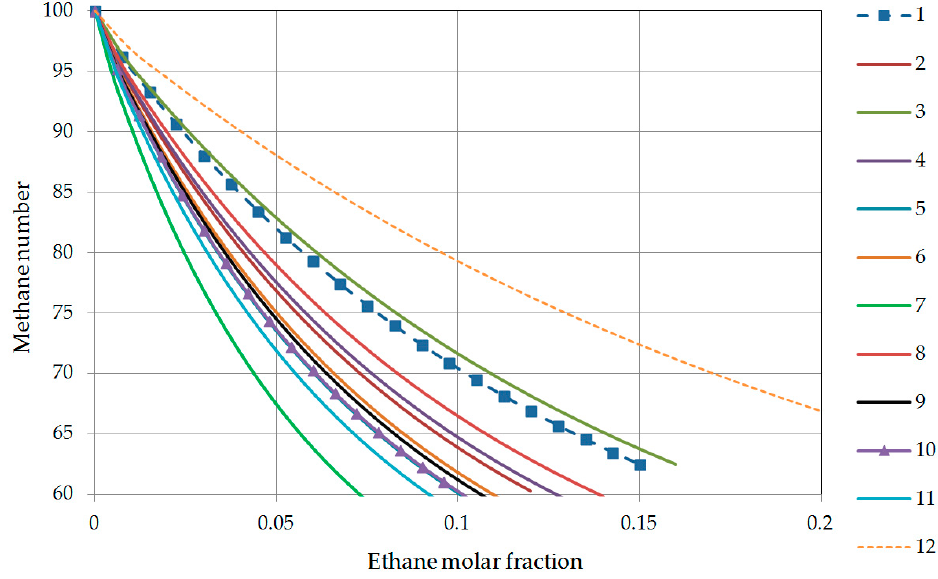
Figure 3. Methane number as function of ethane molar fraction in analyzed LNG composition sets .